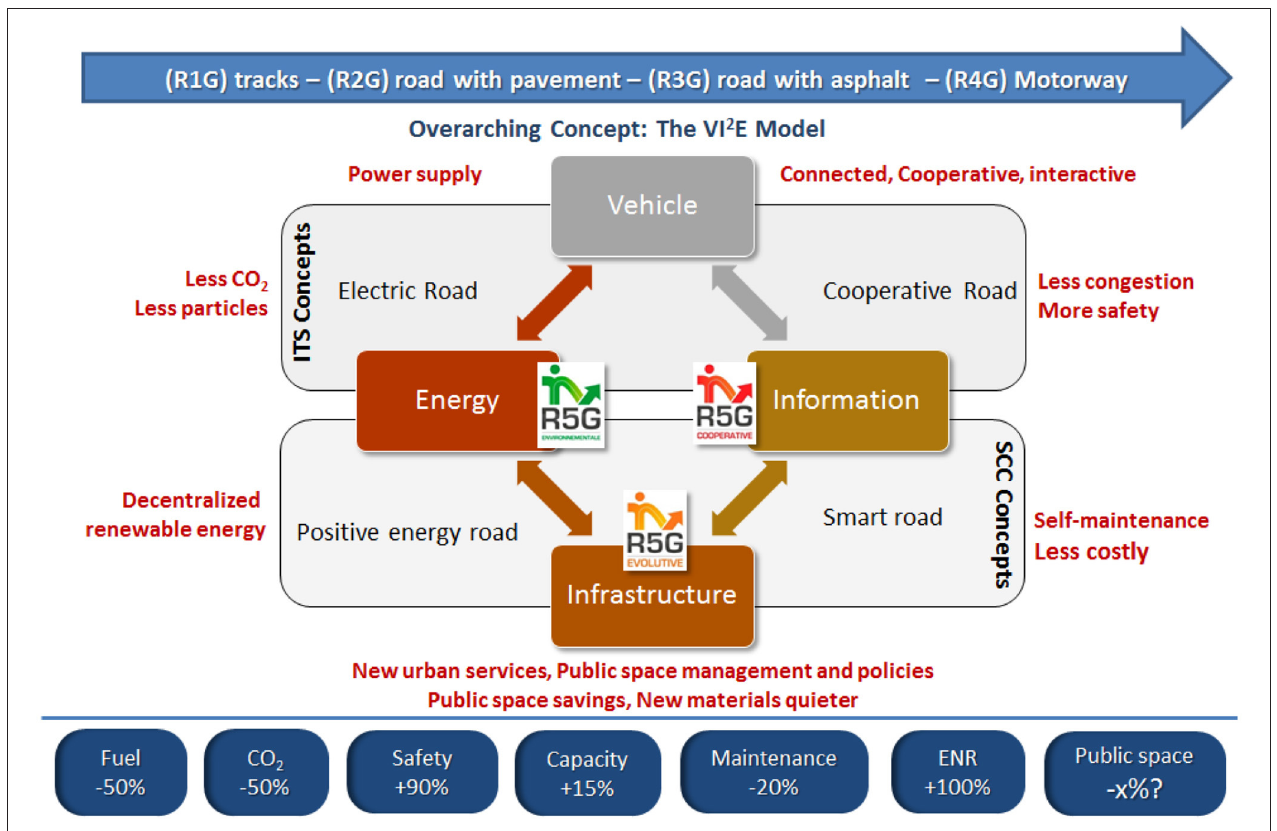
FIGURE 14 | R5G, the 5th Road Generation for a smart, sustainable, and resilient infrastructure useful for CAVs